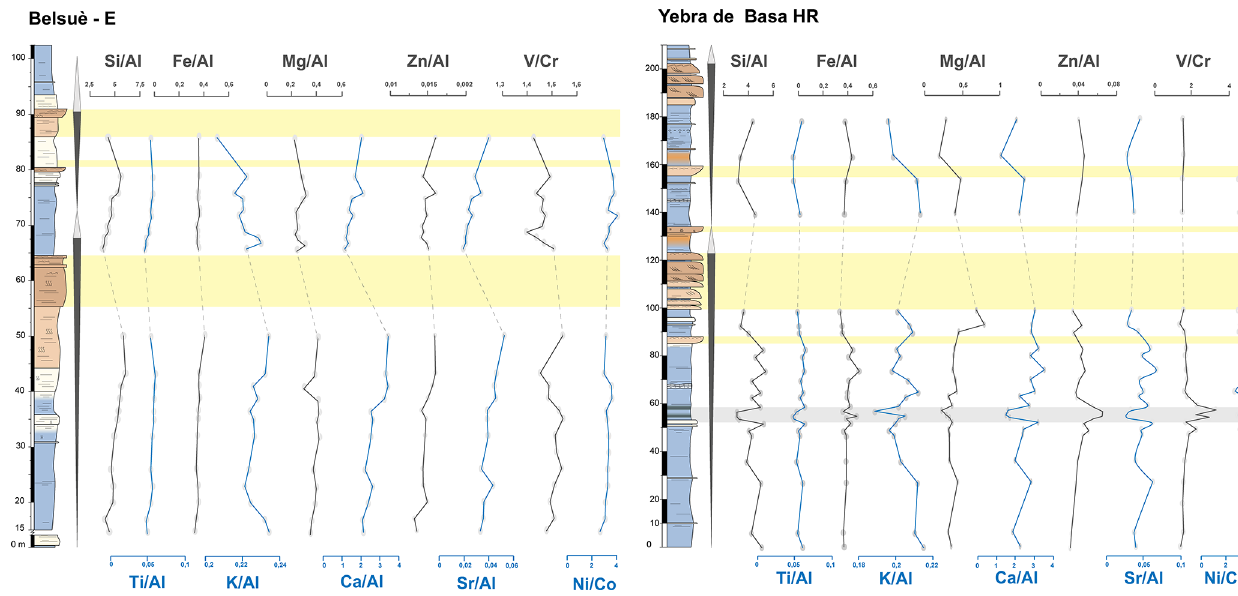
Figure 6. Stratigraphic profiles of Belsué – E and Yebra de Basa HR with the normalised major element concentrations (Si, Fe, Mg, Ti, and K), trace element concentrations (Sr and Zn), and trace element ratios (Ni / Co, V / Cr, and U / Th). The progradation–retrogradation cycles (P–R) are drawn with grey and white triangles. They are highlighted: in pale yellow, the sandstone levels, and in pale grey, the OM-rich interval in Yebra de Basa. The dashed lines represent non-sample